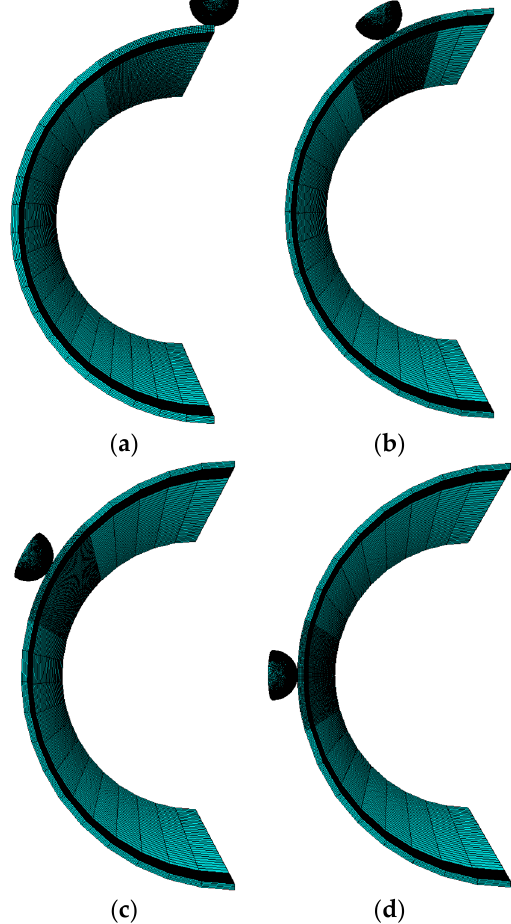
Figure 2. Illustration of the four locations: ( a ) 0°; ( b ) 30°; ( c ) 60°; ( d ) 90°.